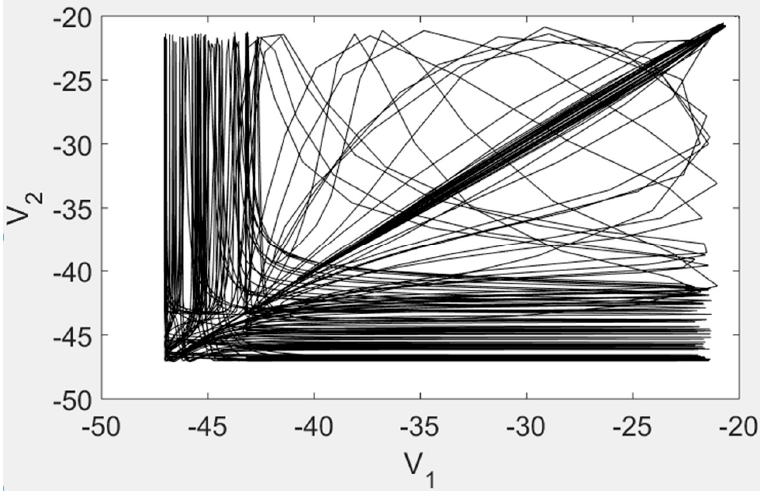
Figure 8. Locus (V 1 , V 2 ) when H syn = 1.55 and τ = 3.4.